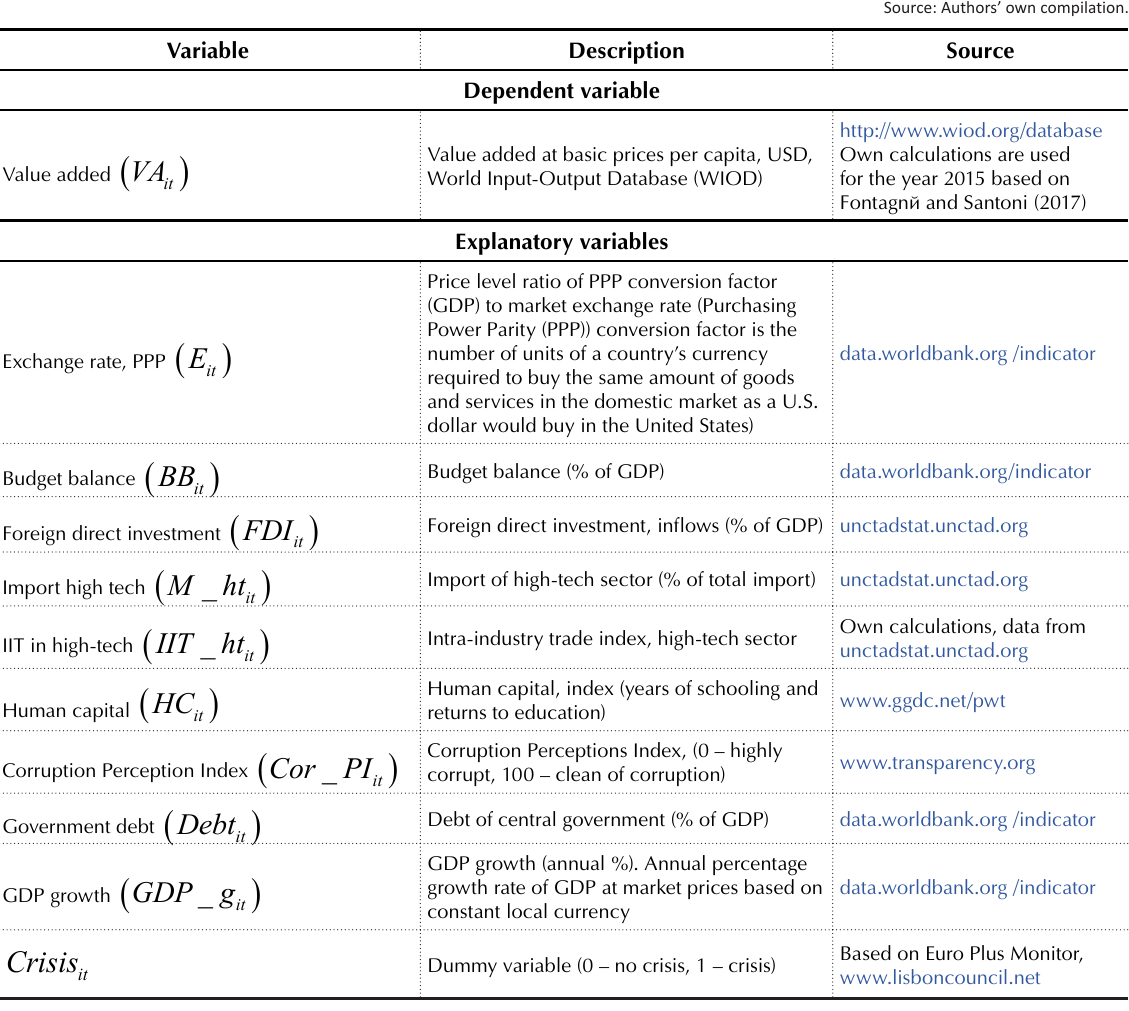
Table 2. Description of the variables